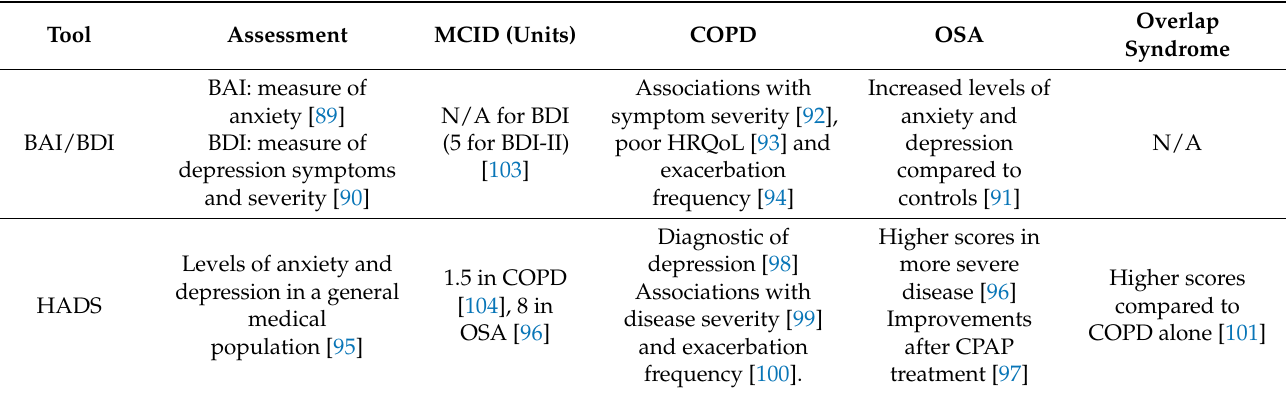
Table 3. PROMs related to mental